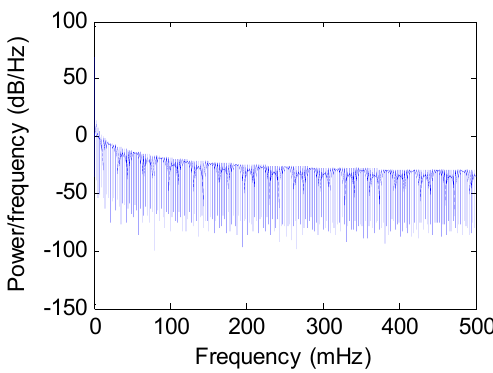
Figure 3. The power spectral density of the gravimeter data before filtering (27